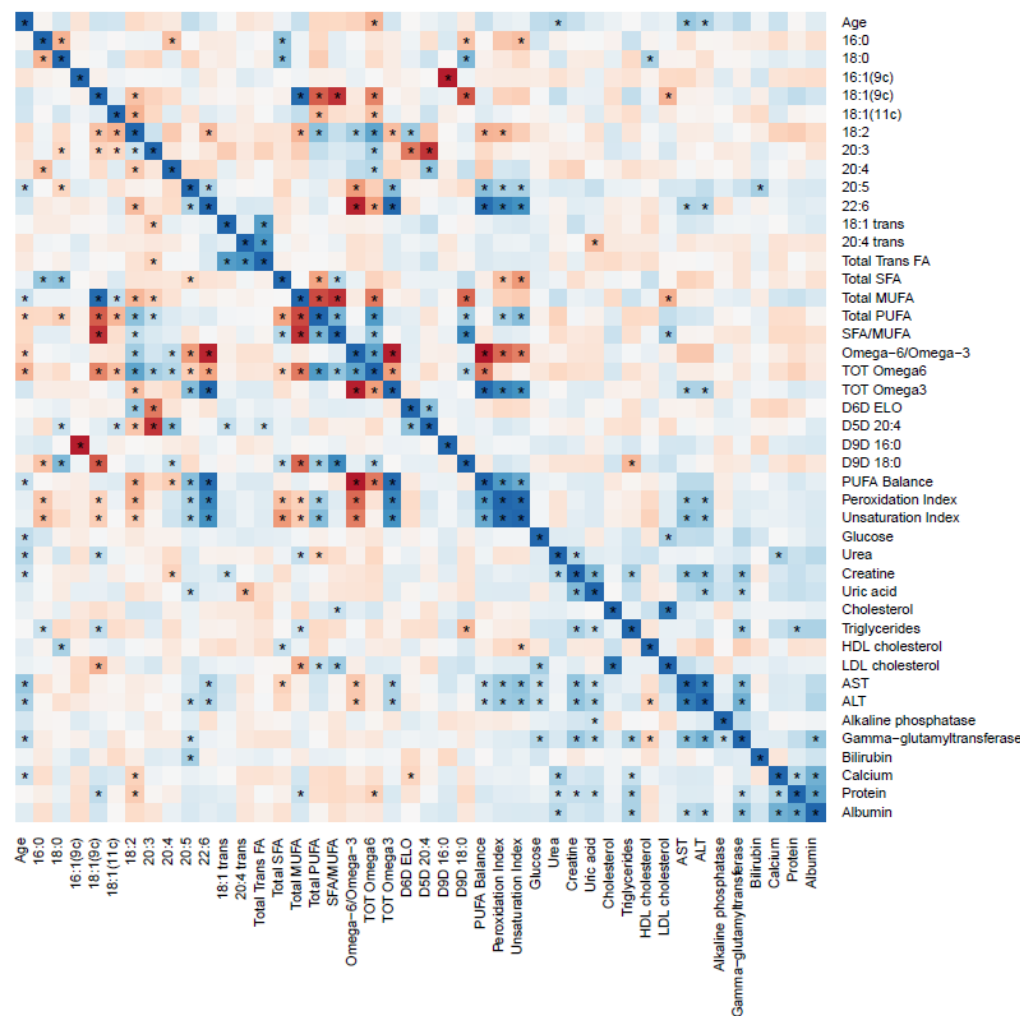
Figure 2. Heat map of the correlations between red blood cell membrane fatty acids and biochemical parameters for adults with obesity. The color represents the Spearman correlation coefficient ( ρ ) (blue = positive; red = negative). * Represent significant correlations ( p < 0.05) between variables. The pair variables that have an * above and below the diagonal line are significantly correlated after correction for multiple comparisons ( q < 0.05).